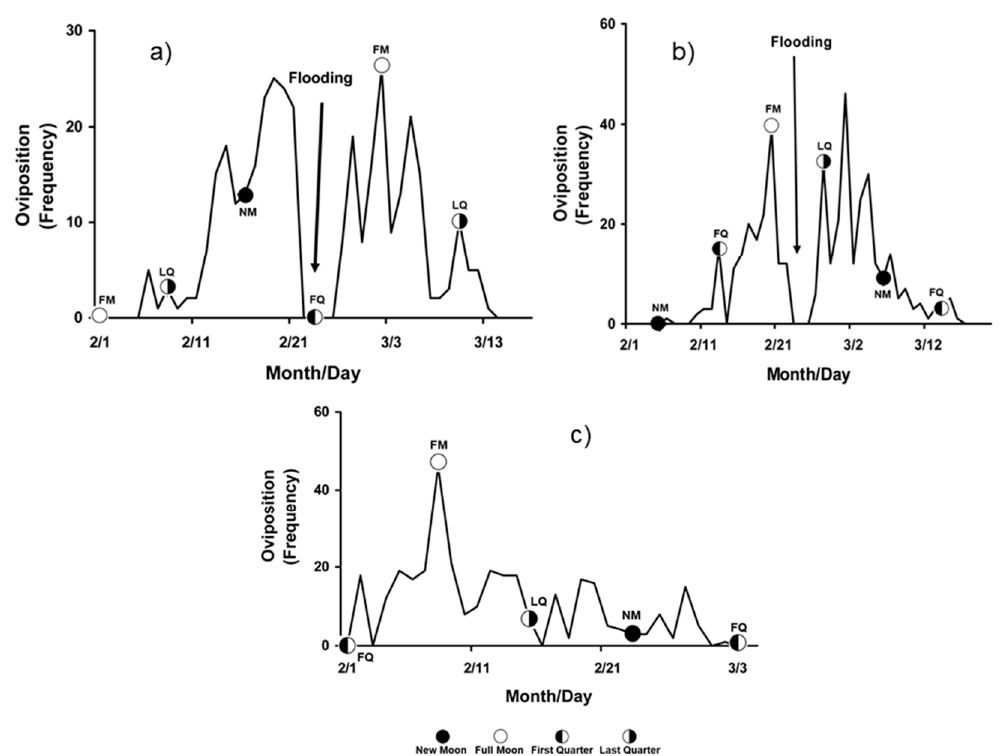
Figure 7. Daily oviposition frequency and lunar cycle in the Tawadu-Nichare Rivers, Venezuela. The three nesting seasons are ( a ) 1999, ( b ) 2000, and ( c ) 2001. Lunar cycle is denoted as: NM = new moon, FQ = first quarter, FM = full moon, LQ = last quarter.